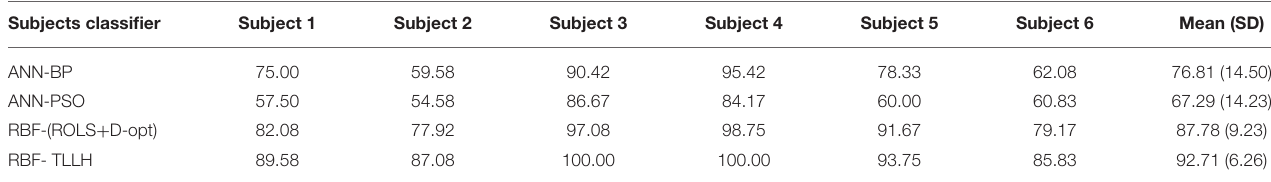
TABLE 1 | Average accuracy (%) of 6-fold cross-validation for each subject using different classifiers.